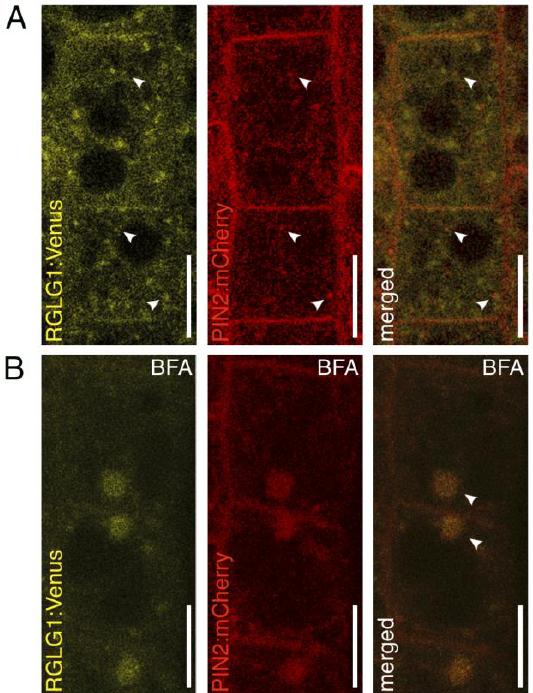
Figure 4. ( A ) RGLG1:Venus (yellow; left panels) and PIN2:mCherry (red; middle panels) in root meristem epidermis cells mock-treated. ( B ) RGLG1:Venus (yellow; left panels) and PIN2:mCherry (red; middle panels) in root meristem epidermis cells treated with BFA (50 μM for 90 min). Accumulation in intracellular compartments (‘ A ’; arrowheads) and in BFA compartments (‘ B ’; arrowheads). Size bars: 10 μm.